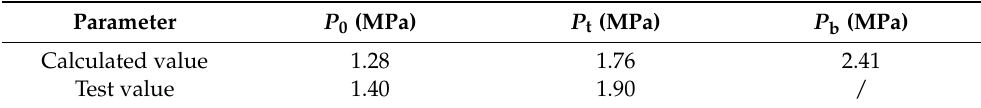
Table 4. Calculation results of P 0 , P t, and P b